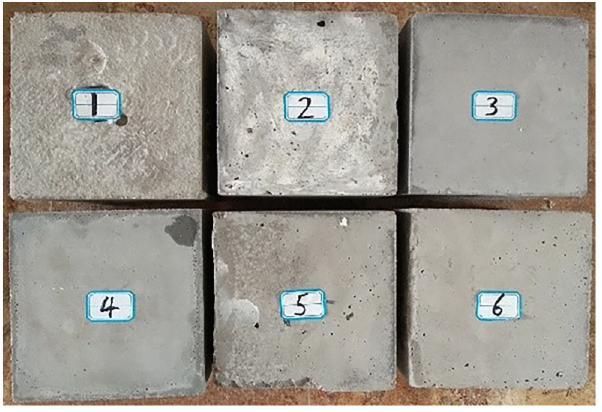
Fig 3. Concrete blocks of different